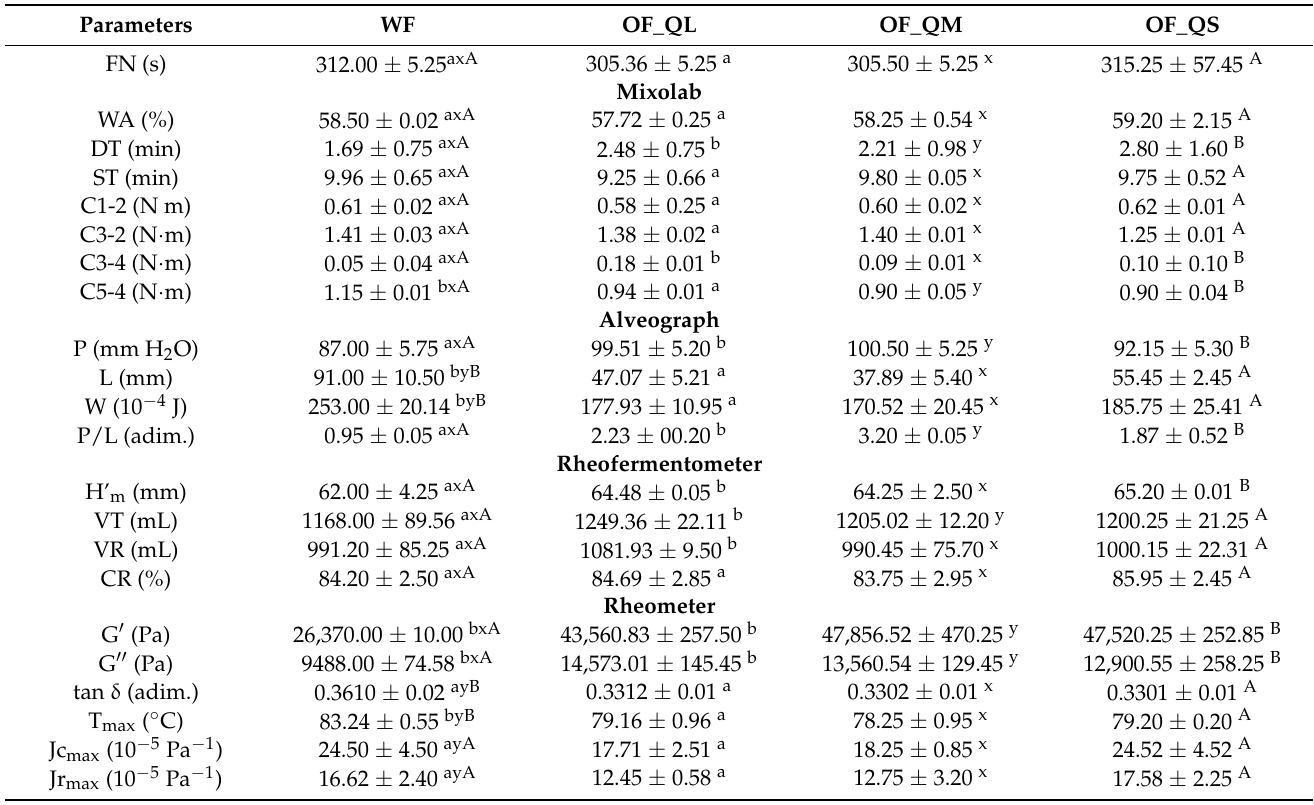
Table 2. The characteristics of the optimal wheat–quinoa composite flour for each quinoa flour particle size and dough rheological